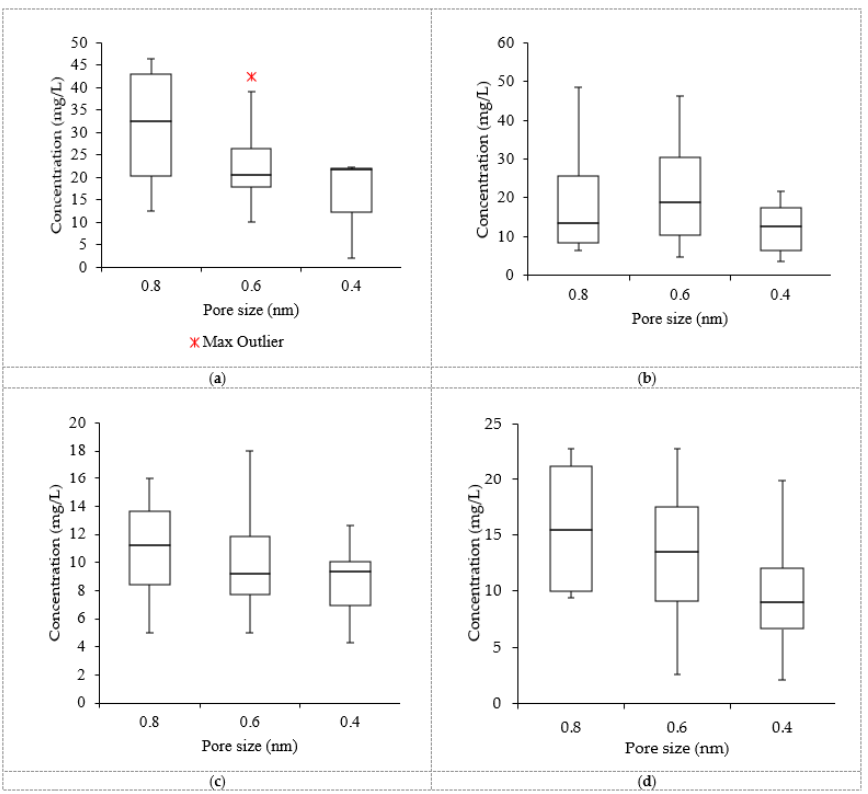
Figure 3. Data distribution from treated effluent from different pore sizes ( a ) ammonia ( b ) total phosphorus ( c ) nitrites ( d ) nitrates.